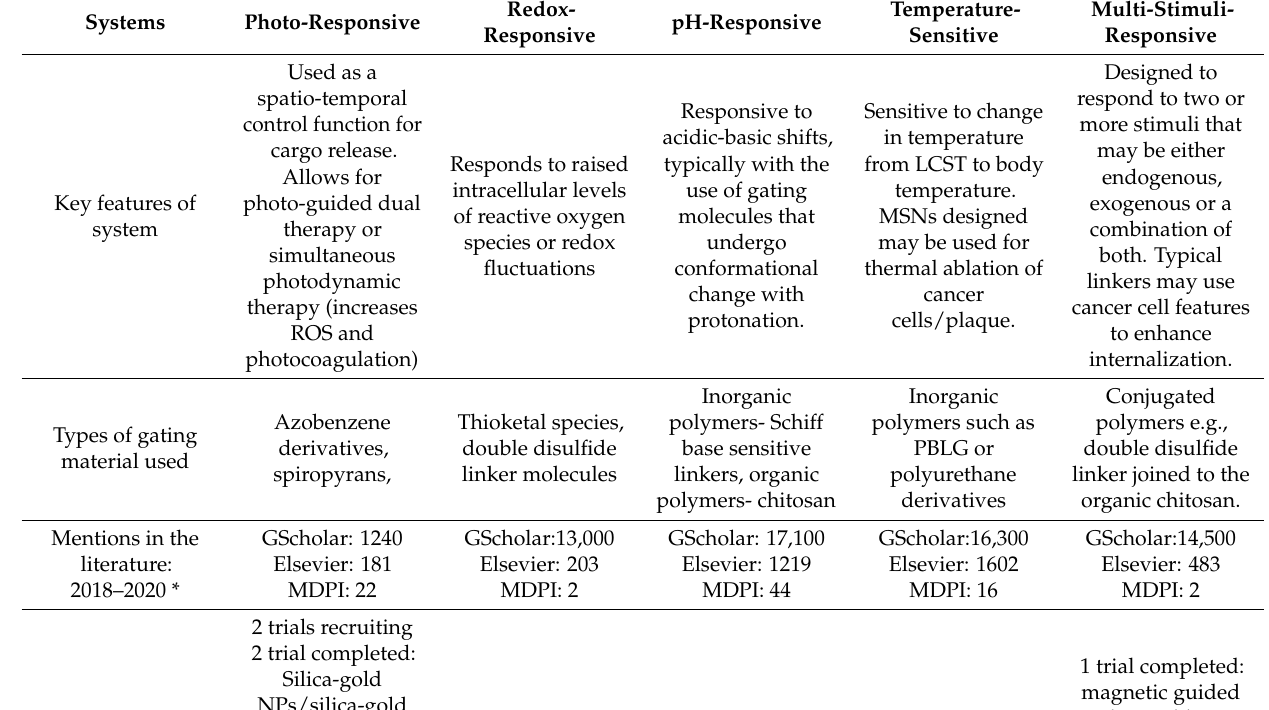
Table 3. Comparison of trends seen in stimuli-responsive